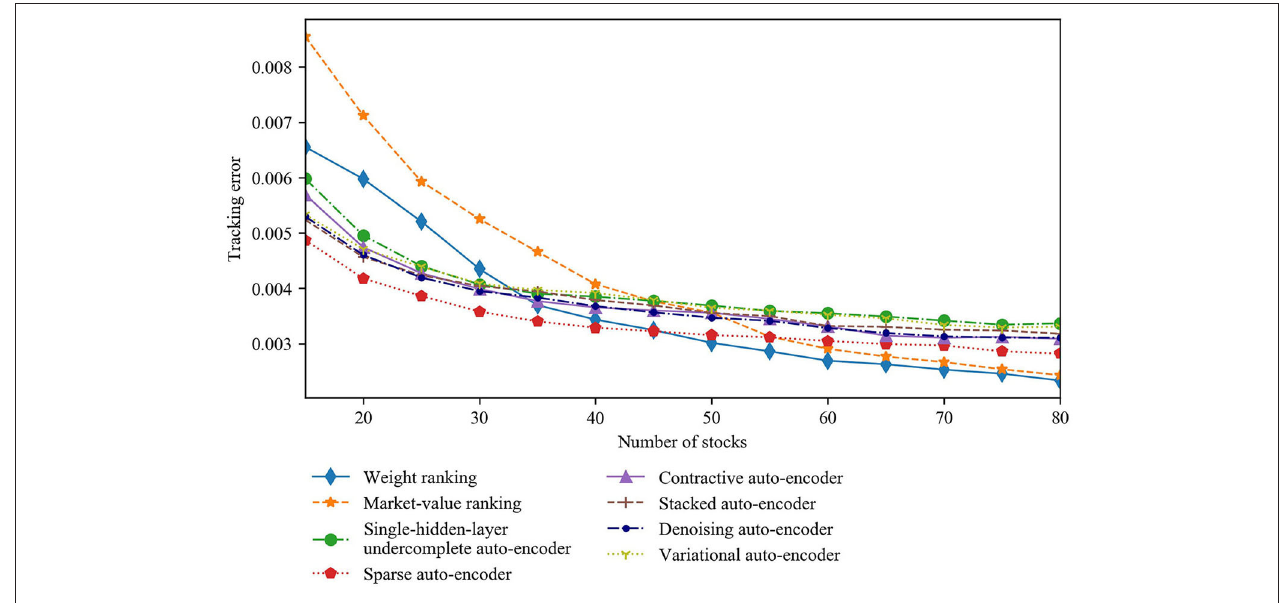
FIGURE 14 | Tracking error curves for all strategies with quarterly rebalancing.